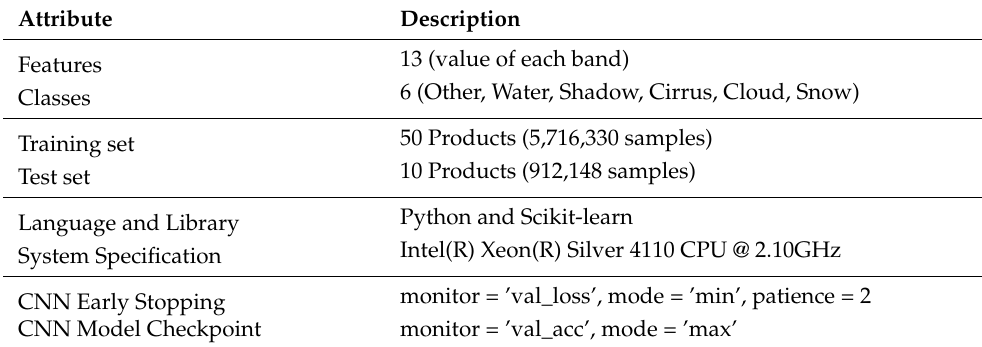
Table 7. Experimental Settings and System